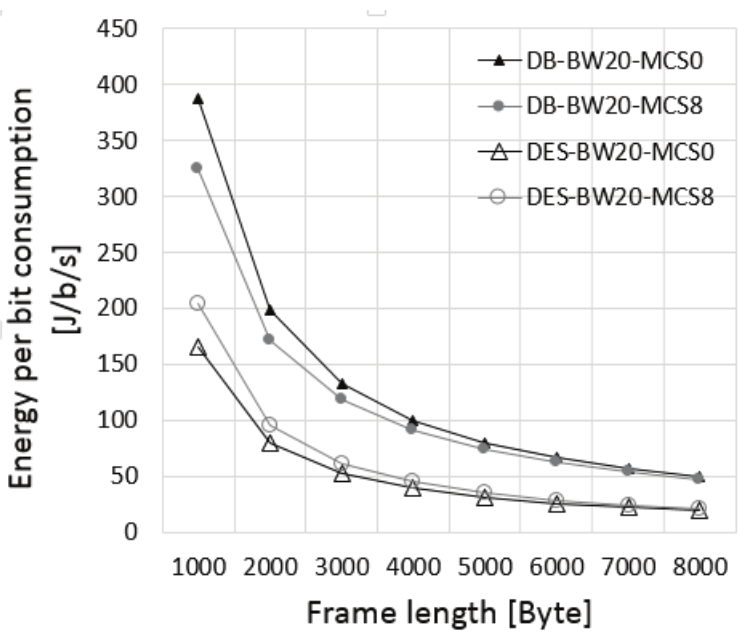
Figure 7. Energy consumption over different frame